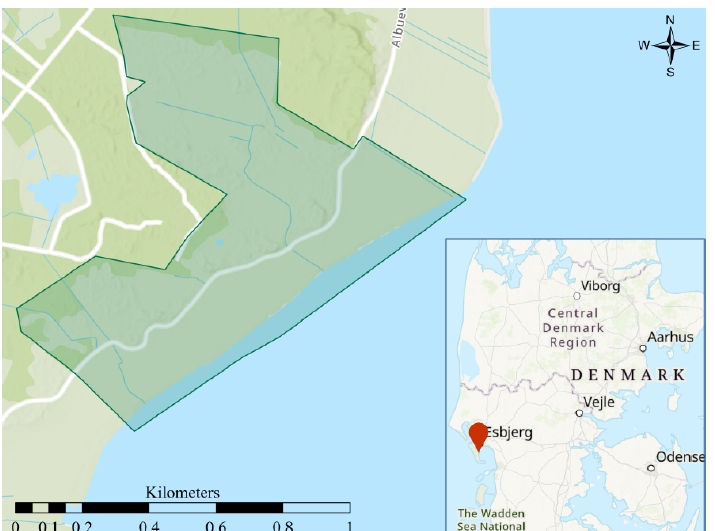
Figure 1. The 65 ha study area on Fanø in the southwest of Denmark. The dark green area marks the area encompassing the largest iteration of the virtual enclosure. The coordinates of the upper left corner of the map frame are 8 ◦ 26 (cid:48) 33 (cid:48)(cid:48) E 55 ◦ 24 (cid:48) 28 (cid:48)(cid:48)